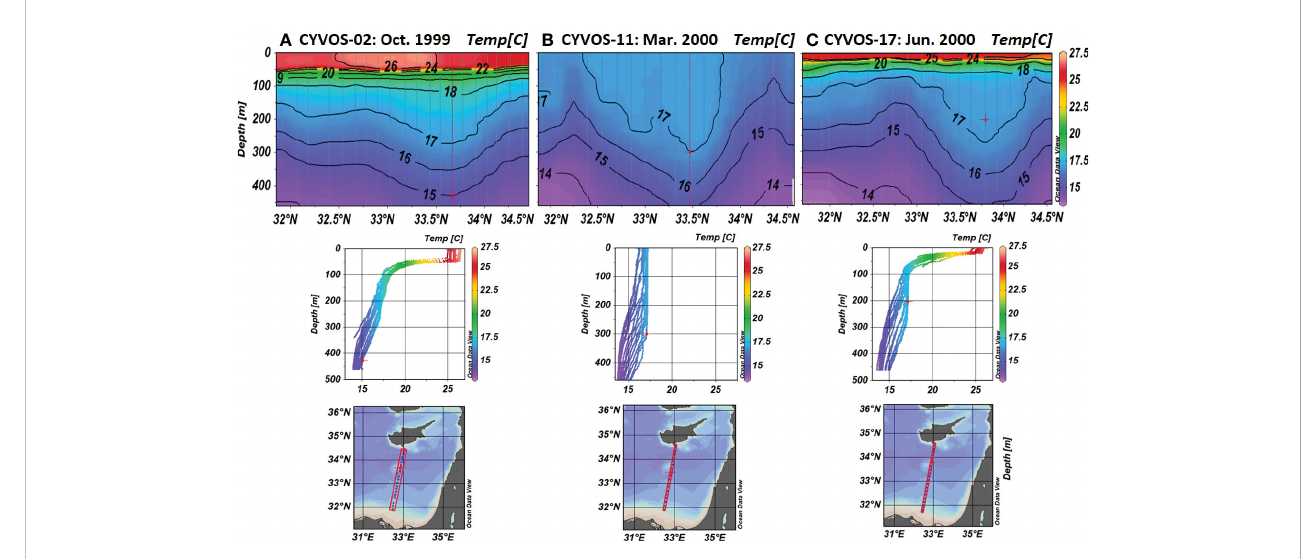
FIGURE 12 Temperature transects and composite pro fi les along the VOS transect from Limassol - Port Said: (A) Oct 1999 (CYVOS2); (B) Mar 2000 (CYVOS 11); (C) Jun 2000